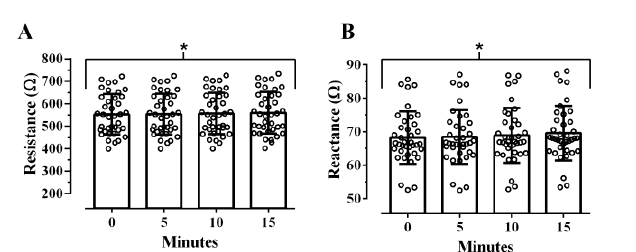
Fig. 1: Effect of time since transitioning from a vertical to a supine position on resistance (A), and reactance (B) over 15 minutes as assessed via the RJL Quantum Legacy analyzer (N=38). Open circles represent individual responses. *Denotes a statistically significant increase from baseline over the course of 15-minutes resting in a supine position (p<0.05).